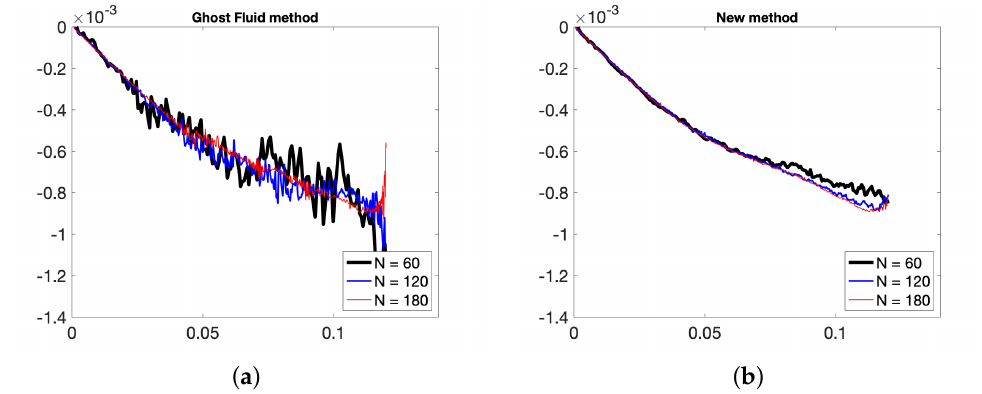
Figure 14. Evolution in time of partial mass of air with N = 60, 90, 120 points in x-direction with ( a ) Ghost Fluid method, ( b ) new method.